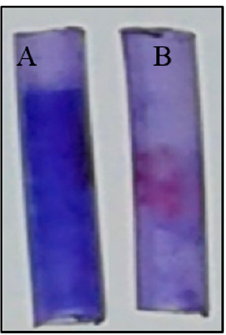
Figure 10. Foley catheters assay: Inhibition of biofilm formed by P. vulgaris NCIM 2027 by biosurfactant (BS) on urethral catheters. ( A ) The control where bacterial biofilm appears as a dark blue colour; ( B ) The test, showing anti-biofilm property of BS against the bacterial strain. Development of biofilm was diminished absolutely on test catheter tubing.